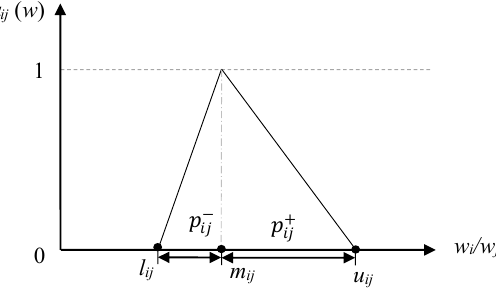
Figure 4. Graphical representation of a membership function, µ 𝑖𝑗 ( 𝑤 𝑖 ,𝑤 𝑗 ) .